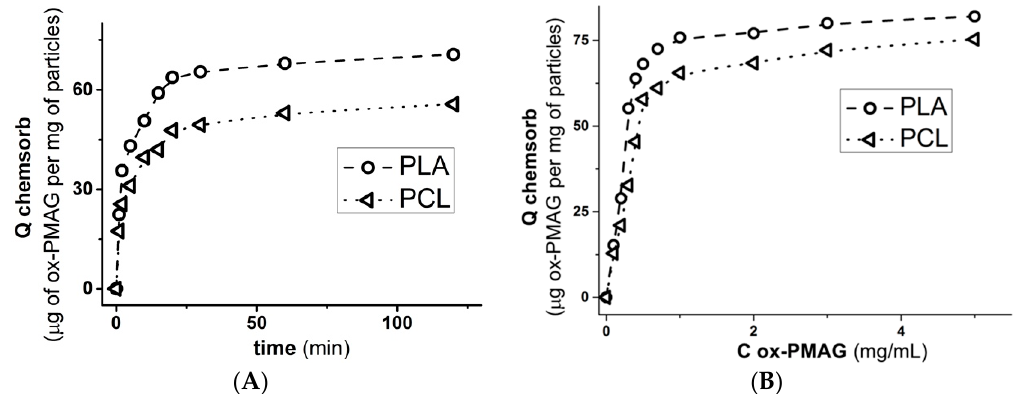
Figure 5. Kinetic curves ( A ) and isotherms ( B ) of ox-PMAG adsorption on the surface of aminated PLA and PCL particles. Conditions: 0.01 M sodium borate buffer solution, pH 8.5, 25 °C, 300 rpm.